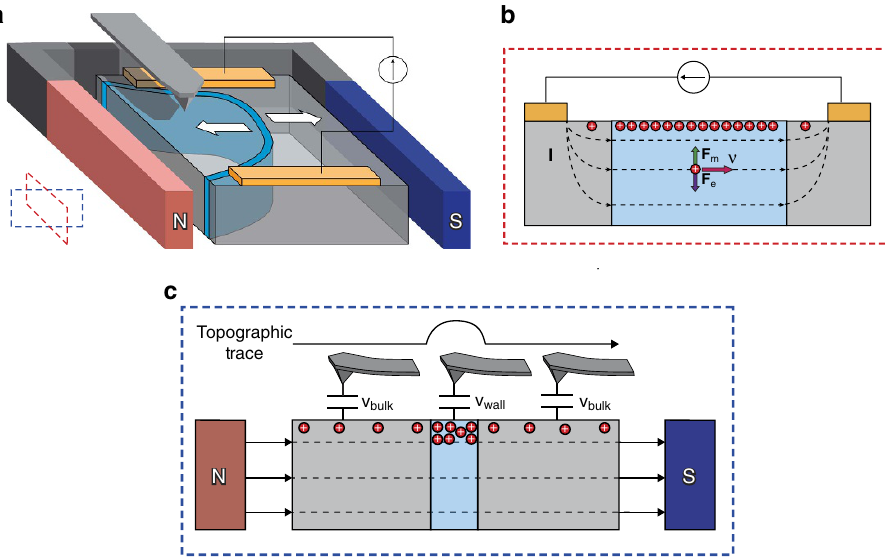
Figure 2 | Schematic of experimental set-up and operation of Hall voltage imaging. ( a ) Schematic of sample geometry. Gold surface electrodes sputtered on YbMnO 3 top surface, trapping a tail-to-tail domain wall, shown in blue. A constant current was driven through the surface electrodes and an in-plane magnetic field was applied to the sample, perpendicular to the driven current. Inset: red and blue dashed boxes indicate the relative orientations of the cross-sections shown in b , c . ( b ) Depiction of the Hall effect on a positive test charge, where symbols are as follows: carrier drift velocity n , Lorentz force F m , Columbic force F e , Current along the wall I . ( c ) An atomic force microscopy probe is rastered across the sample surface in tapping mode. It acts as an earthed electrode in a capacitor structure, sensing spatial changes in force-gradients associated with variations in the potential difference between tip and sample surface ( V bulk within domains and V wall at the domain wall). The Hall potential developed causes V wall to be distinct from V bulk , allowing domain wall contrast to appear in the topographic image.